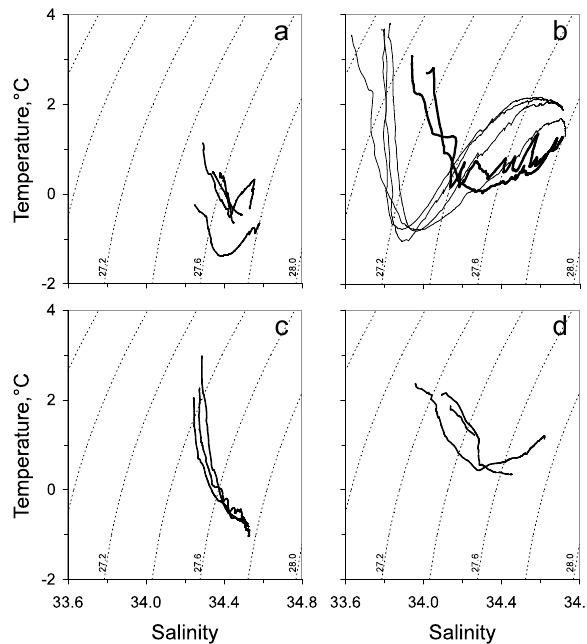
Fig. 2. Temperature/Salinity diagrams for the 16 stations where wa- ter samples were obtained for determination of Fe concentrations. Note that CTD profiles were obtained from the surface to 750m, or to within ∼ 10m of the bottom at the shallower stations (bottom depths are given in Table 2). For station locations, see Fig. 1b. (a) , group A stations (#1 to 4); (b) , group D stations (#10–13) with light lines, and group C Stations (#8–9) with dark lines; (c) , group B sta- tions (#5–7); (d) , group E stations (#14–16). The thin dotted lines show isopycnal intervals (sigma-q) in temperature/salinity